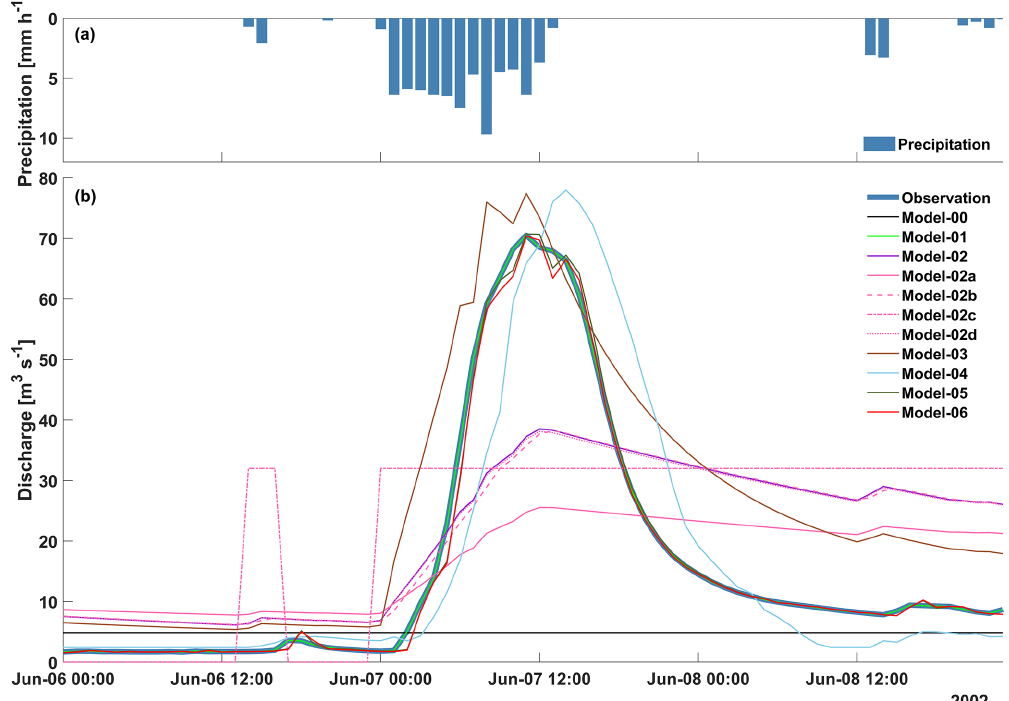
Figure 3. (a) Observed precipitation at Ebnit. (b) Observed discharge at gauge Hoher Steg and simulations thereof by Model-00 to Model-06 for a rainfall-runoff event in June